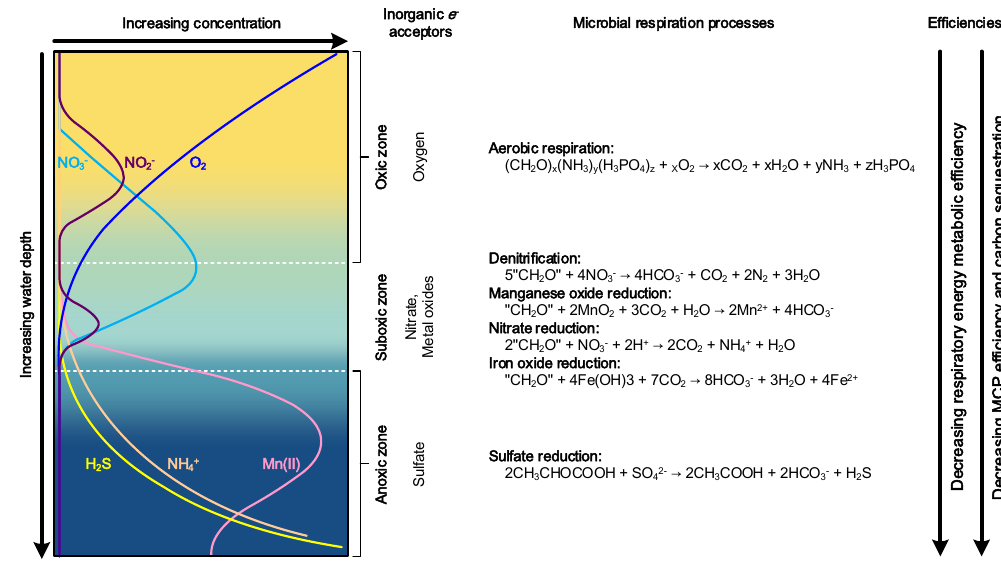
Figure 6. The influence of microbial respiration processes on the efficiency of the MCP. Left panel after Moore et al. (2009).